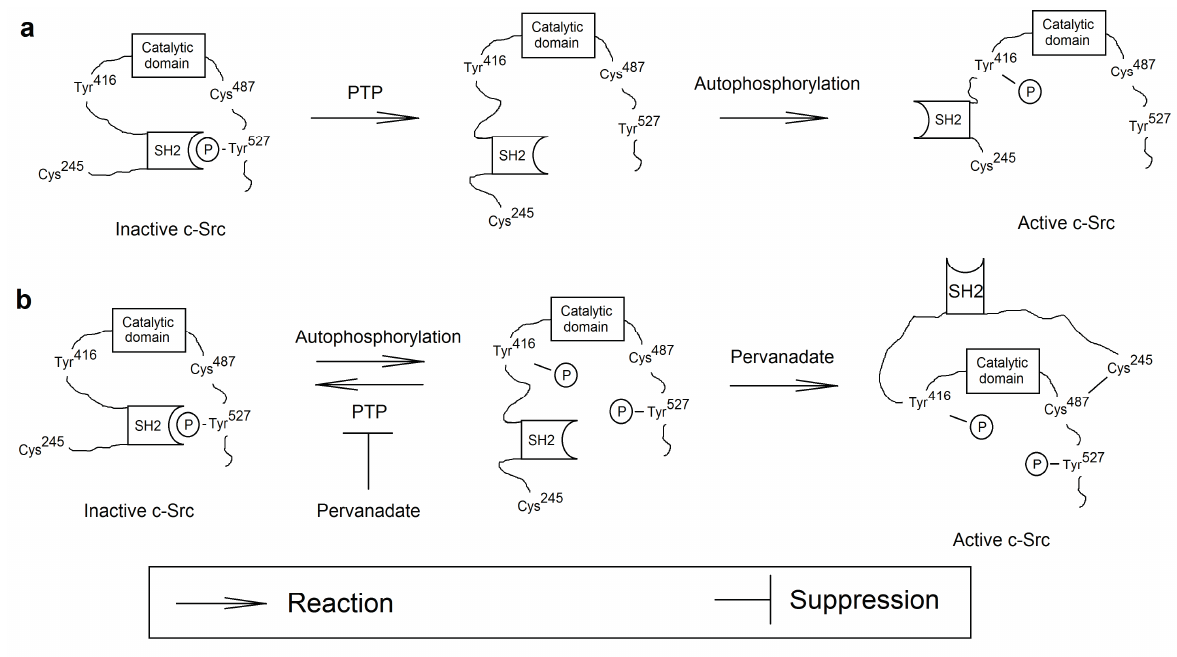
Figure 4. The proposed mechanism of c-Src activation of vanadium